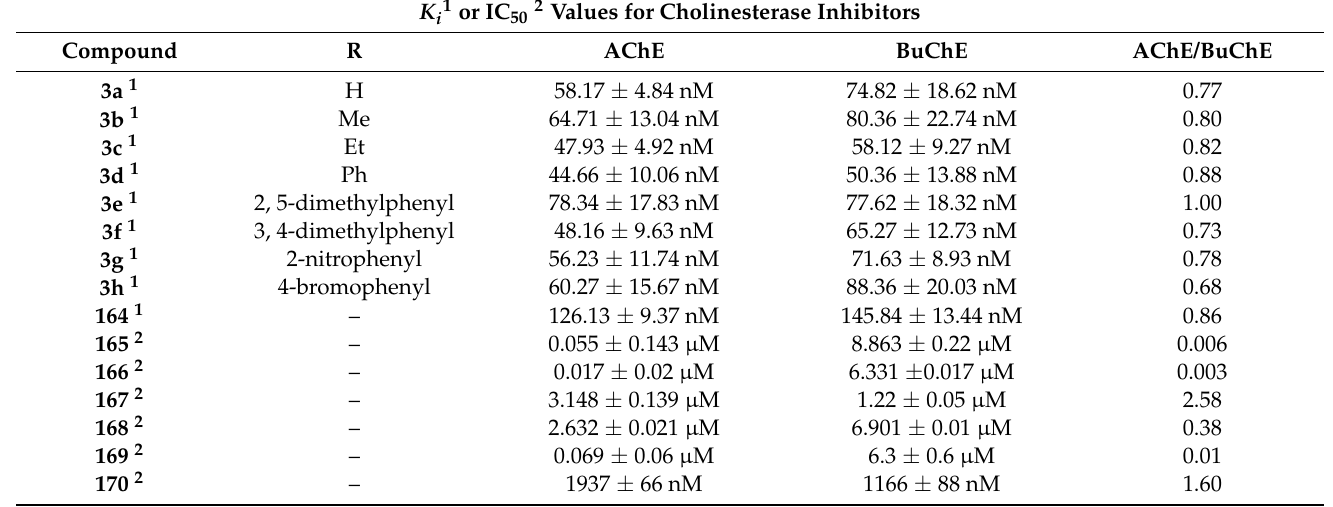
Table 1. Affinities of cholinesterase